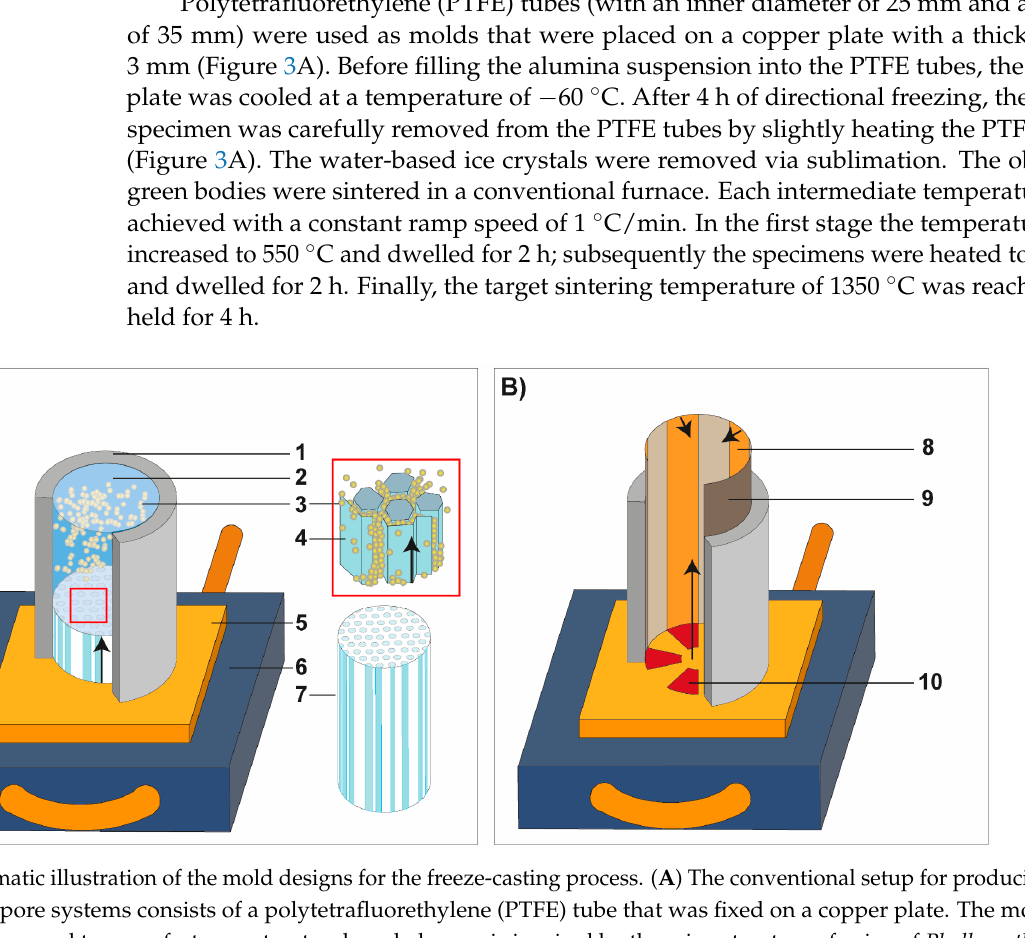
Table 1. Concentration of the solid loading of Al 2 O 3 and gelatin of the water-based alumina suspensions.